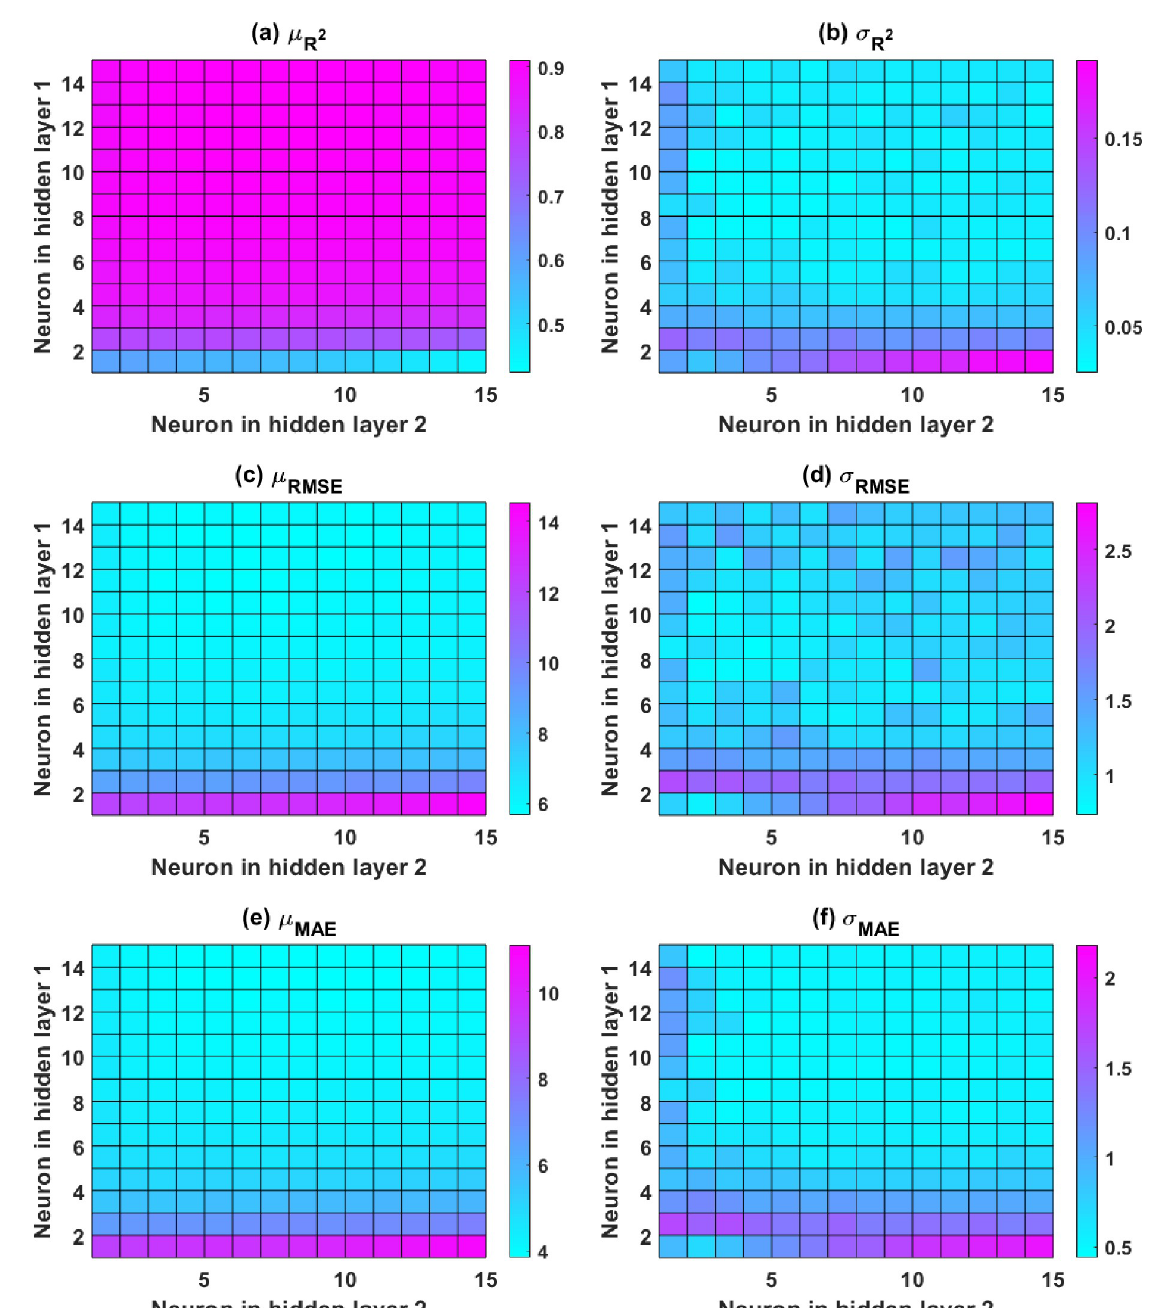
Fig 6. Color-map of ANN with two hidden layers for the testing part in relation to (a) mean R 2 ; (b) StD R 2 ; (c) mean RMSE; (d) StD RMSE; (e) mean MAE; and (f) StD MAE. For a better description of ANN model performance in the case of 2 hidden layers, the per- formance values of 225 ANN architectures are described by color map in Fig 6 for the testing part. Only the results from the testing dataset are considered here because the testing data reflects the model’s accuracy and predictability in the regression problem. Fig 6A and 6C and 6E